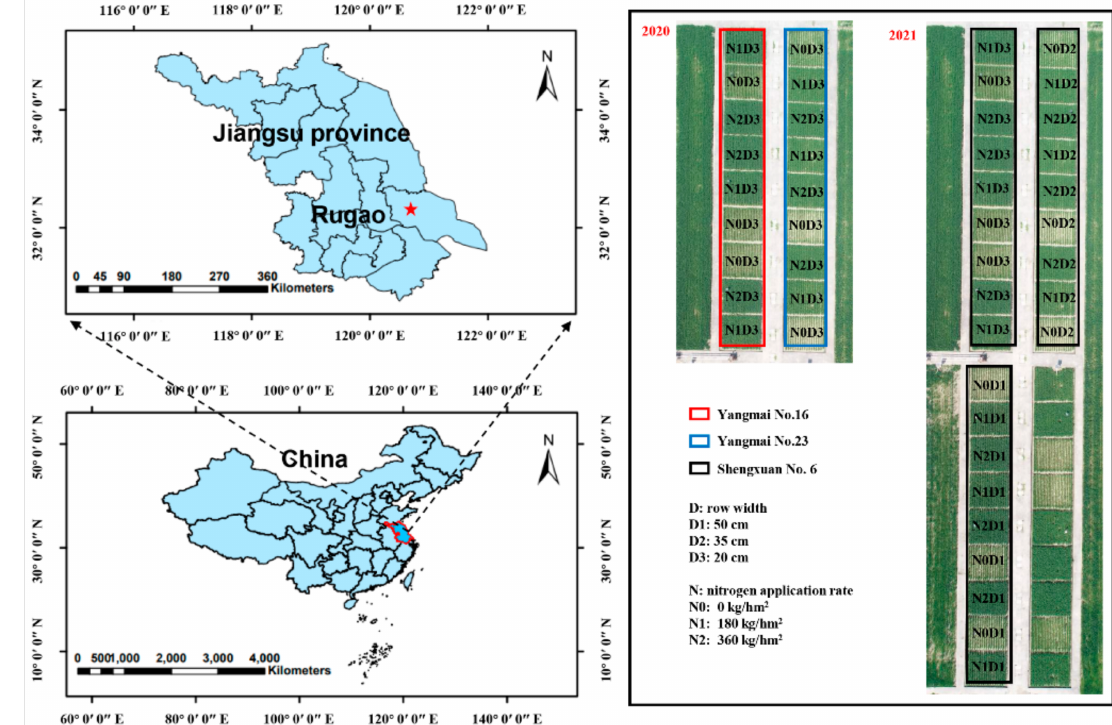
Figure 1. Location of the experimental field.